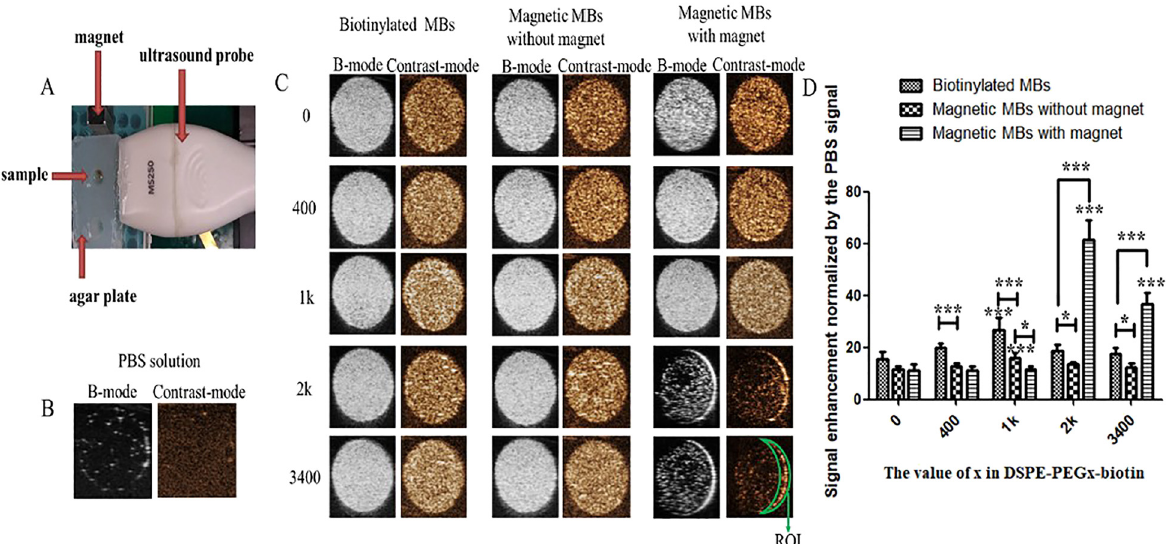
Figure 6: (A) Schematic diagram of the setup for acquiring ultrasonograms whilst applying a magnet. (B) The ultrasonogram of PBS solution. (C) B-mode and contrast-mode ultrasonograms of biotinylated and magnetic MBs suspensions in PBS without and with magnet application (5 × 106/mL, pH 7.4, B ≈ 1.2 T). (D) In vitro echogenicity at the region of interest (ROI) of MBs measured as signal enhancement normalized to the PBS solution signal. Data represent mean with SD, n = 5. * p < 0.05, ** p < 0.01, *** p <